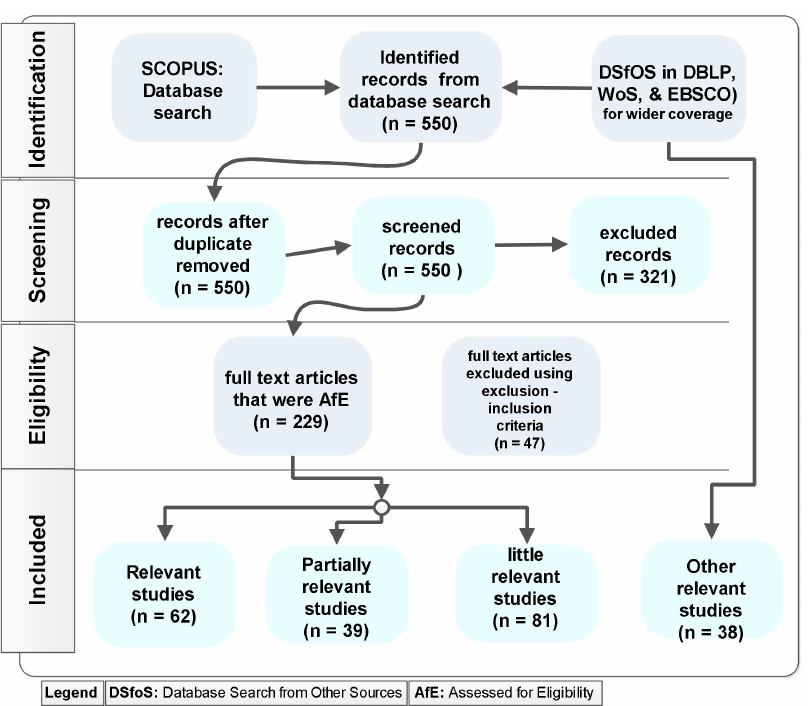
Figure 5. The systematic review procedure using